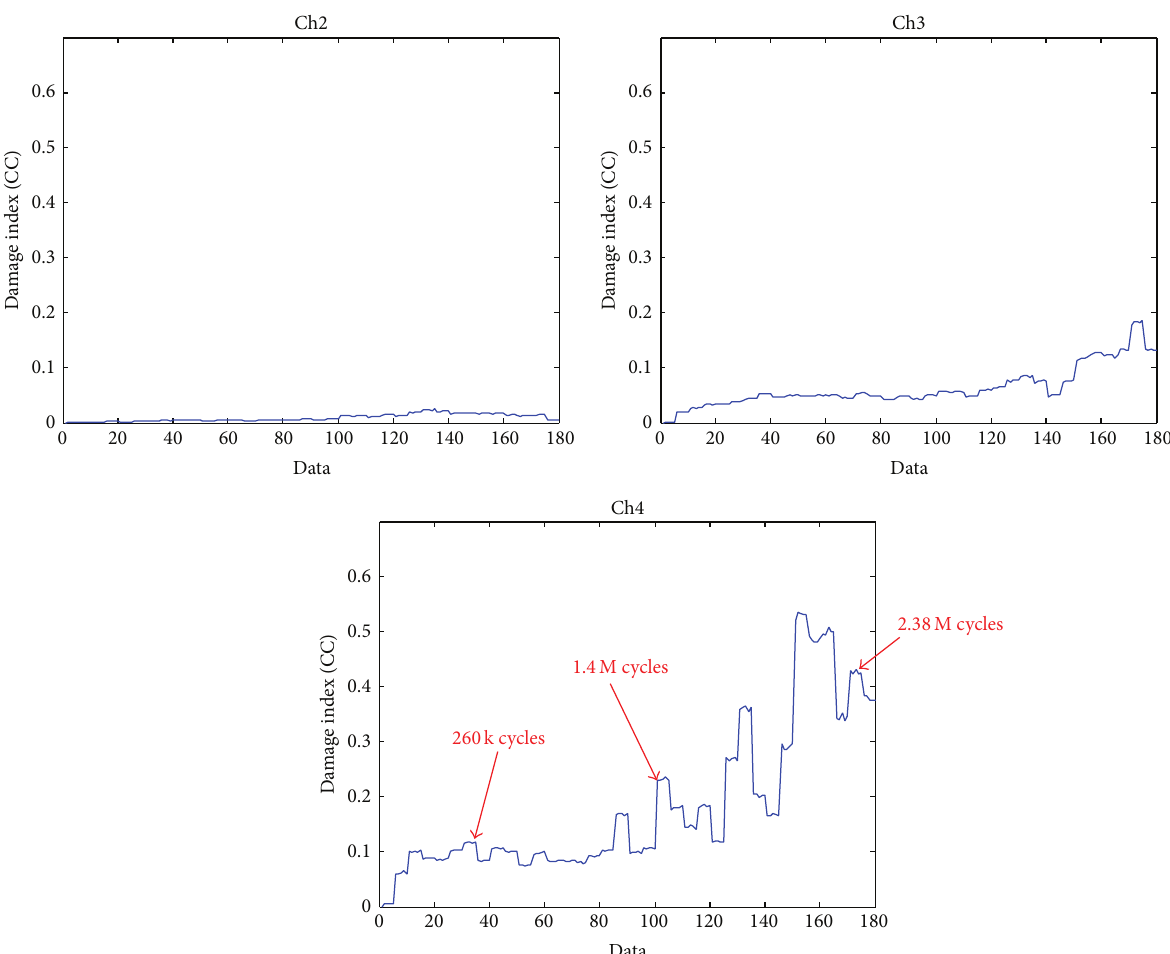
Figure 10: FRF-based DI values which are compared to a baseline for Ch2–4. DI is obtained between the current measurement and the